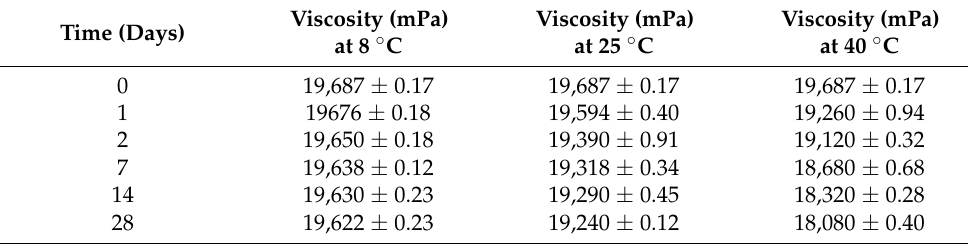
Table 3. Viscosities of optimized naproxen-eugenol emulgel at different temperatures and time. Viscosity (mPa) Time (Days) at 8 ◦